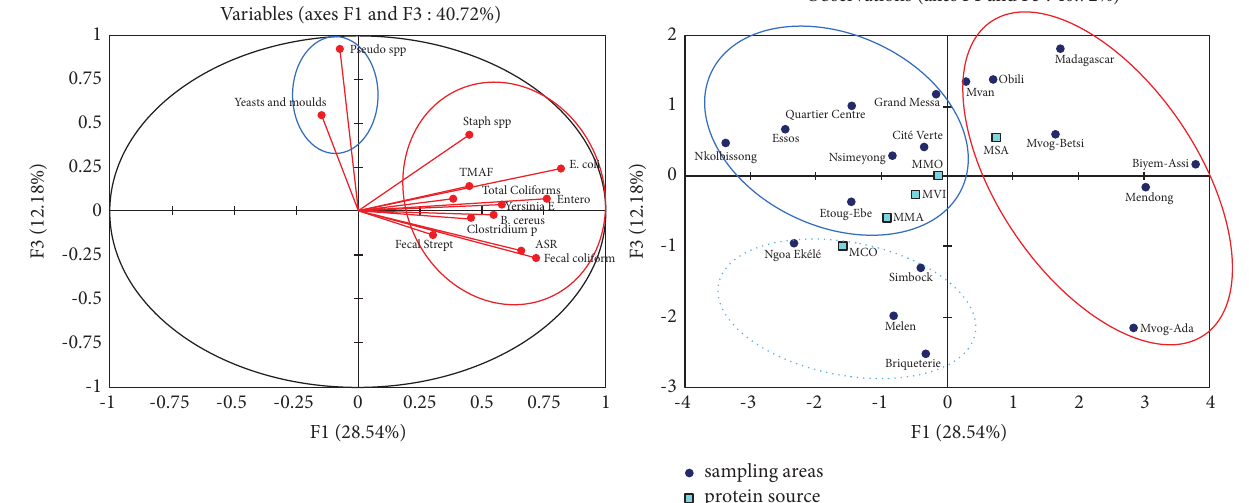
Figure 1: Distribution of the studied parameters on the axis systems F1 & F3. � sampling areas; � protein source; TMAF � total mesophilic aerobic flora, Entero � enterobacteria, Fecal strept � Fecal streptococci ; Staph spp. � Staphylococcus spp. ; Yersinia E � Yersinia enterocolitica, ASR � anaerobic sulfite-reducing bacteria; MCO � Egusi pudding free of protein source; MMO � Egusi pudding with cod as protein source; MMA � Egusi pudding with mackerel as protein source; MSA � Egusi pudding with sardine as protein source; MVI � Egusi pudding with beef as protein